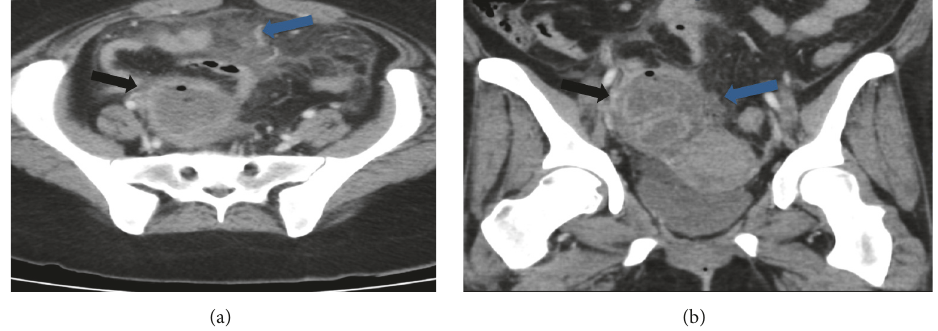
Figure 1: Patient’s computed tomography (CT) scan of the abdomen and pelvis before surgery. Figure 1(a) Transverse view. Figure 1(b) Coronal view. Black arrow demonstrates right adnexal peripherally enhancing mass with extensive surrounding inflamatory changes and foci of air compatible with tubo-ovarian absess (TOA). Blue arrow demonstrates extensive inflitration of teh mesentery with inflamatory changes as well as fluid concerning for TOA rupture and seeding of the mesentary.